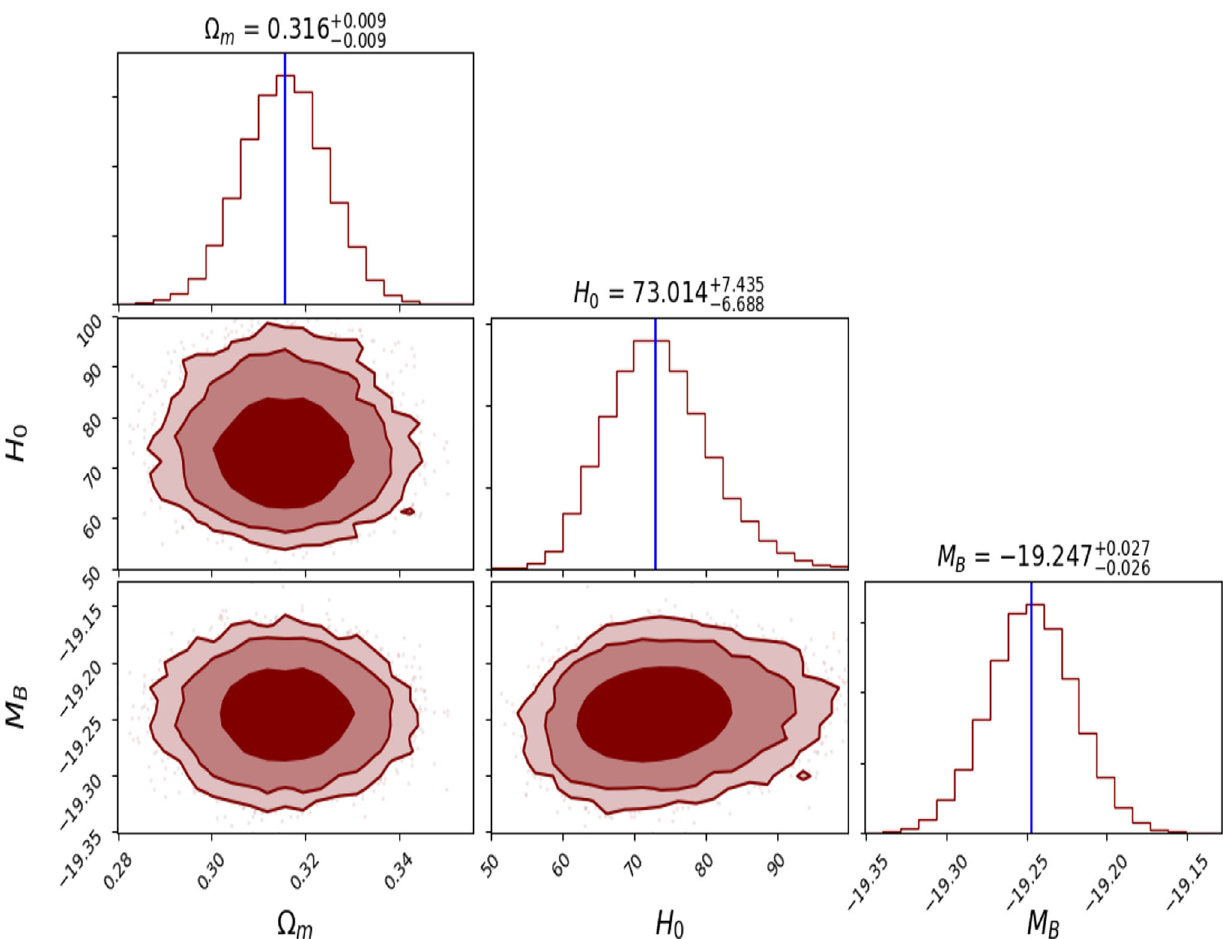
Fig. 5 The 1-D marginalized likelihood distributions along with 2-D marginalized constraints showing the 68%, 95%, and 99% confidence regions for the parameters (cid:3) m , H 0 , and M B , obtained using the Corner python module [57]